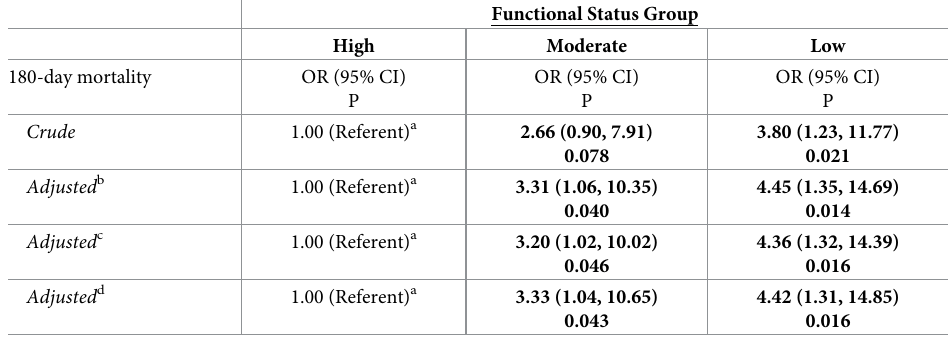
Table 3. Unadjusted and adjusted associations between functional status category and 180-day mortality (N =